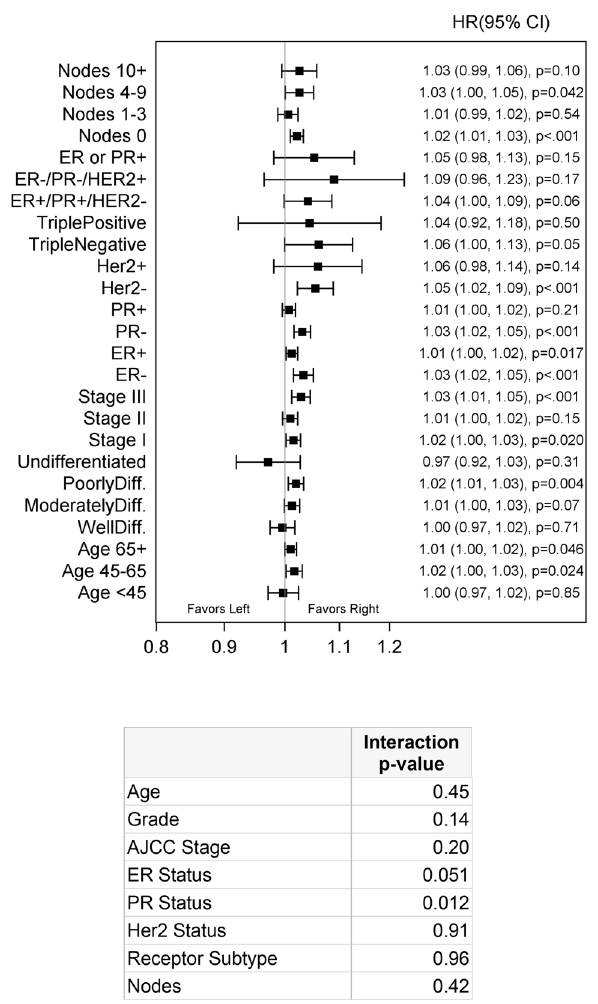
Figure 1. The Surveillance, Epidemiology, and End Results (SEER) program: interaction analysis. ER estrogen receptor, PR progesterone receptor, HER2 human epidermal growth factor receptor 2, AJCC American Joint Committee on Cancer, Diff